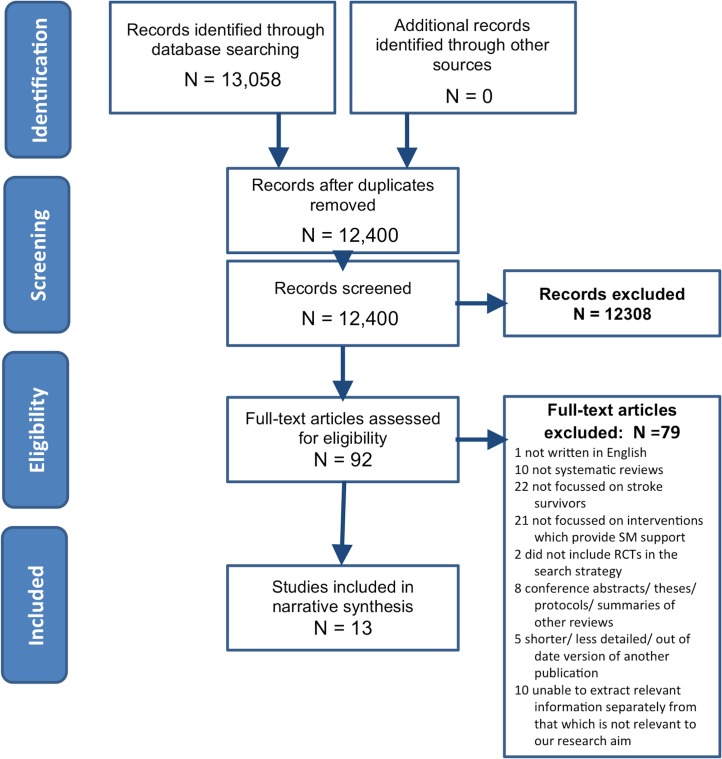
PRISMA flow chart.